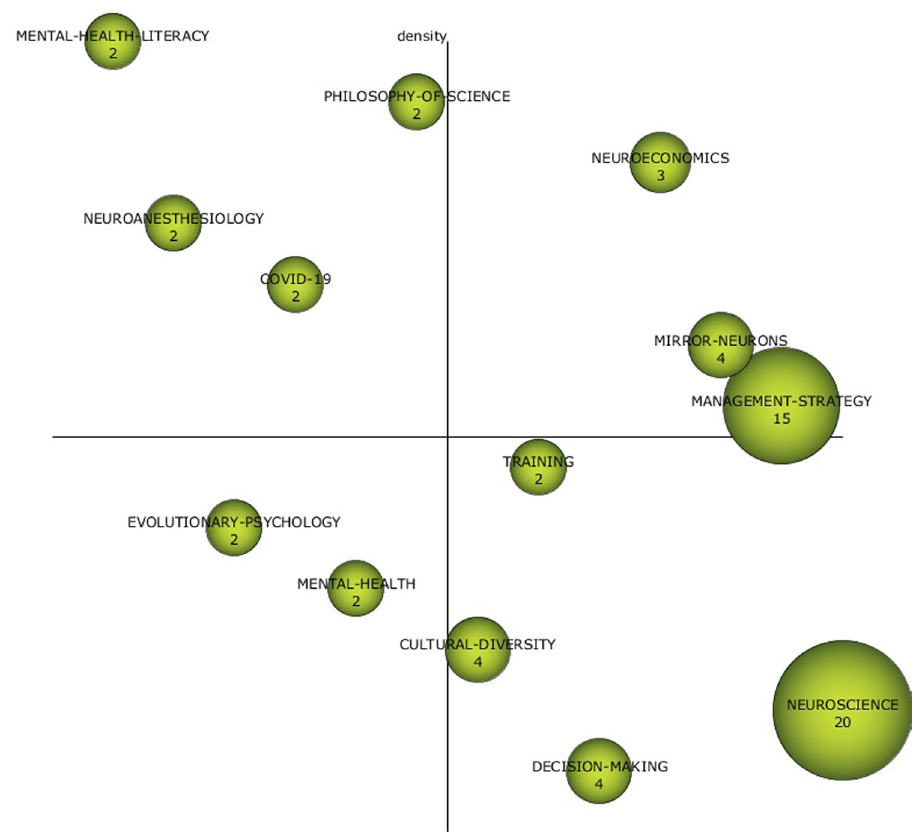
Fig. 1 Strategic diagram (1992 – 2022). Results from SciMat, diagram composed of themes by number of documents for all the period (1992 –